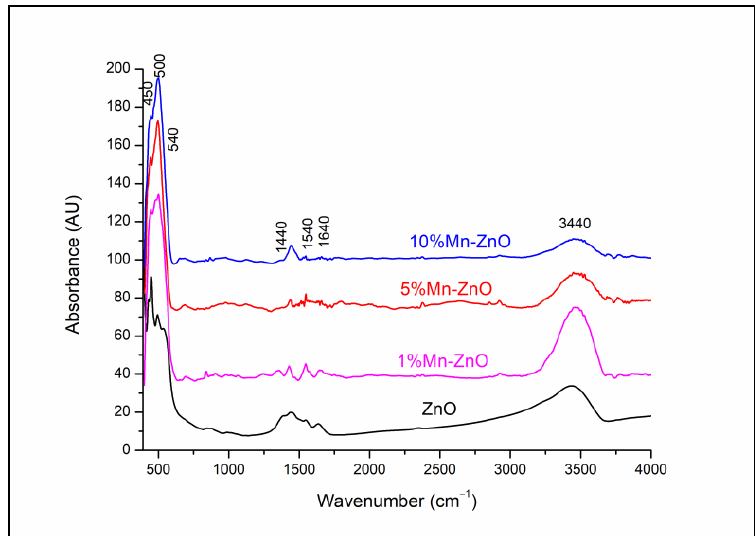
Figure 2. FTIR spectra of x%Mn-ZnO nanoparticles.